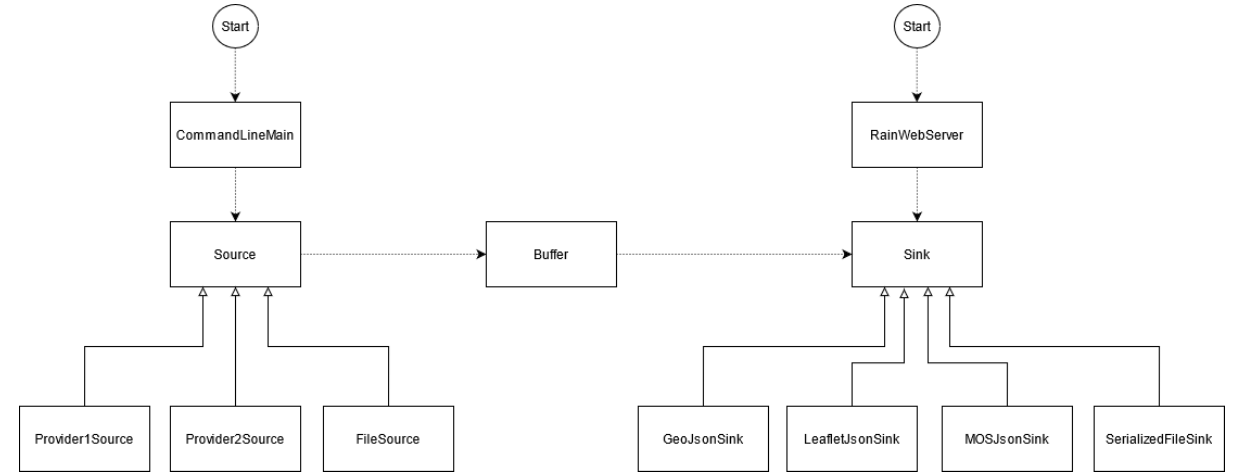
Figure 8. Internal structure of our implementation.